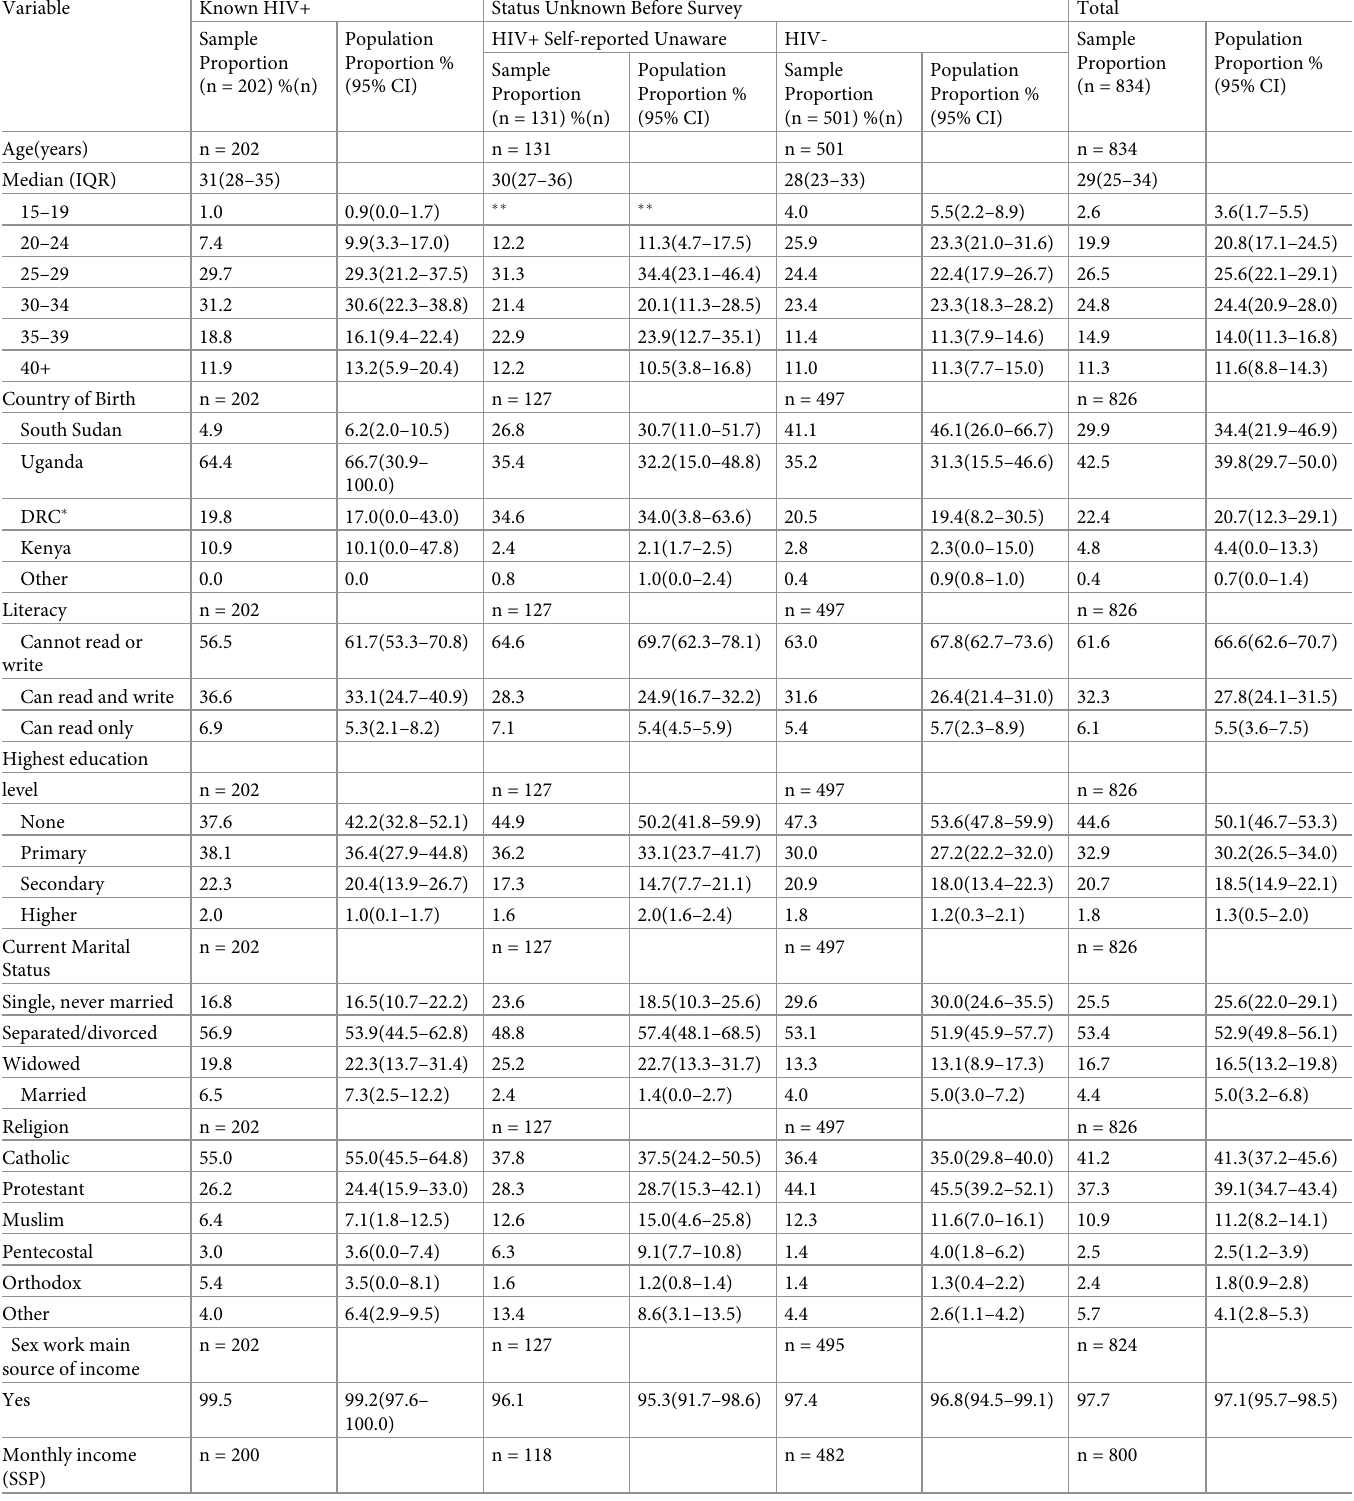
Table 1. Background characteristics of female sex workers in Juba, South Sudan,